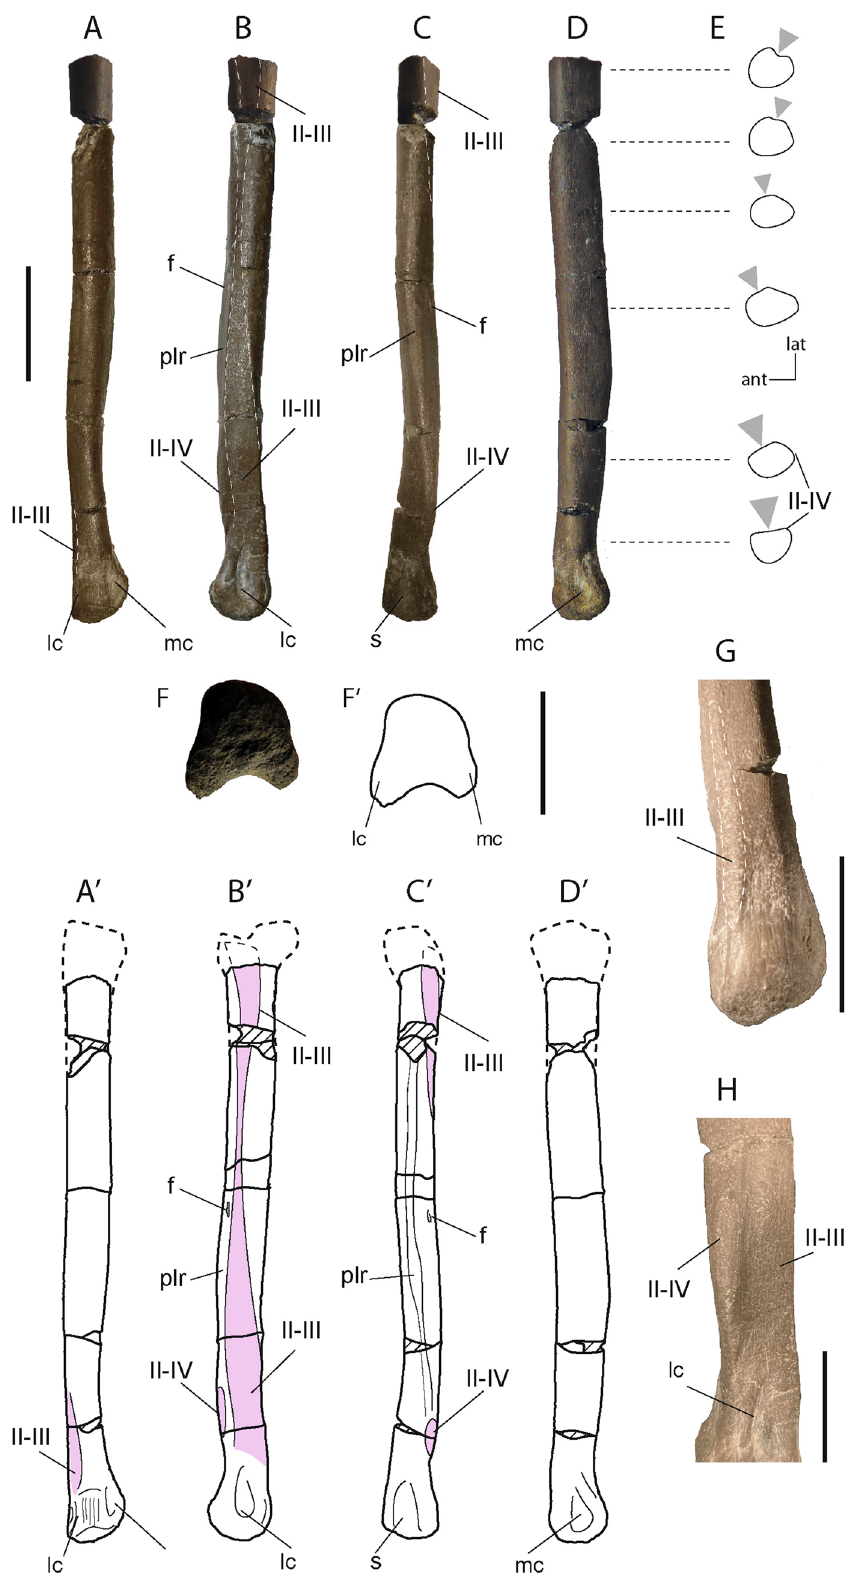
Figure 2. The European troodontid Tamarro insperatus (MCD-7073) gen. et sp. nov. from the uppermost Maastrichtian of the Tremp Group, Tremp Basin, Southern Pyrenees. Photographic and interpretative ilustrations of the right second metatarsal in anterior ( A-A’ ), lateral ( B-B’ ), posterior ( C–C’ ), medial ( D-D’ ), and distal ( F - F’ ) views. Scheme illustrating the gradual transition of the articular surface–grey arrow–for the accommodation of the metatarsal III ( E ). Detail of the distal end of the metatarsal II in anterior view showing the anterior contact surface of the metatarsal III ( G ). Detail of the articular surface of the metatarsal IV in the posterodistal part of the second metatarsal ( H ) ant anterior; f foramen; lat lateral; lc medial condyle; mc, lateral condyle; II–III contact between the second and third metatarsals; II–IV contact between the second and fourth metatarsals; plr plantar ridge; s